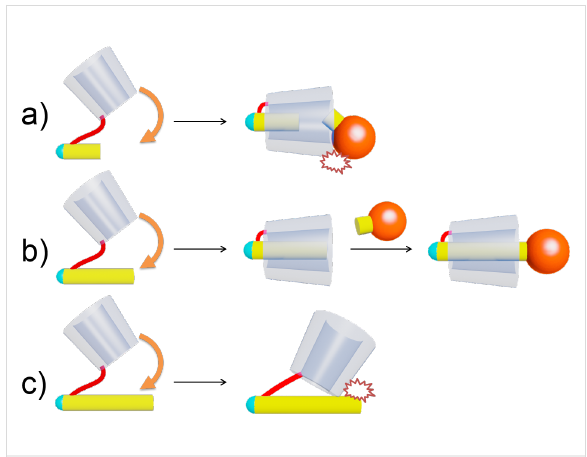
Figure 1: Synthesis of [1]rotaxane by self-inclusion of a host–guest- linked molecule: a) short molecular length, b) appropriate molecular length, c) long molecular